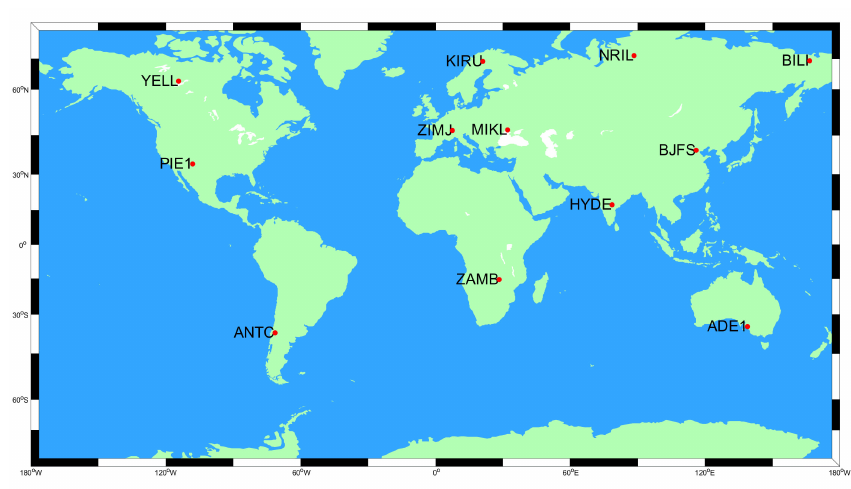
Figure 1. The distribution of 12 IGS stations in the PPP